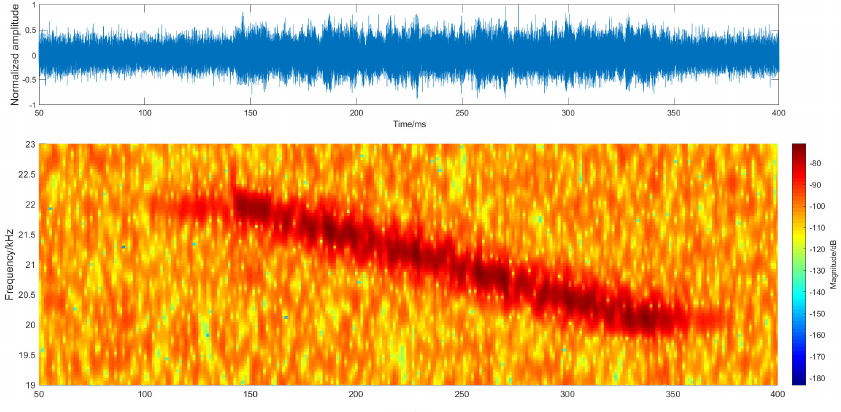
Figure 7. The waveform of received signal processed by TR.